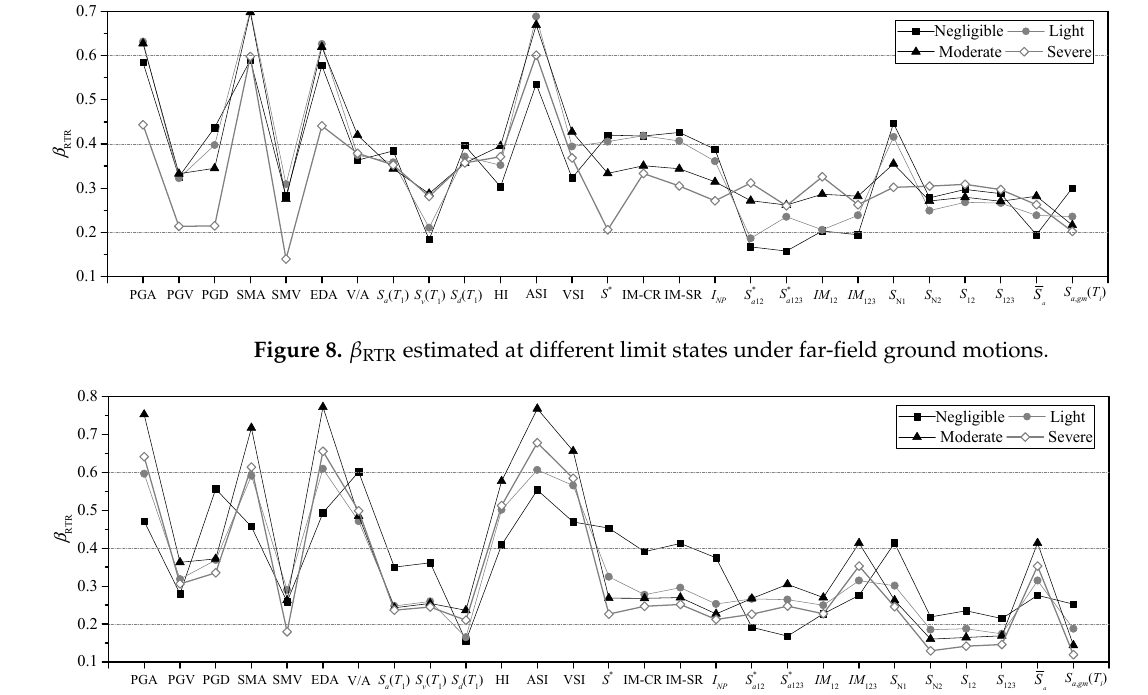
Figure 8. β RTR estimated at different limit states under far-field ground motions. Figure 9. β RTR estimated at different limit states under near-field ground motions.